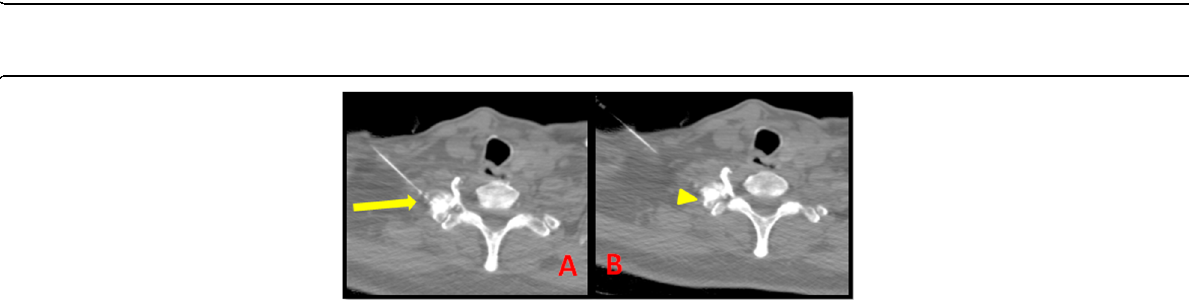
Fig. 10 Anterior approach in stellate ganglion block for Pancoast tumor. Axial CT section ( a ) of the pre-procedure showing the needle tip in the stellate ganglion and post-procedure ( b ) free flow of contrast (arrowhead) in the stellate ganglion